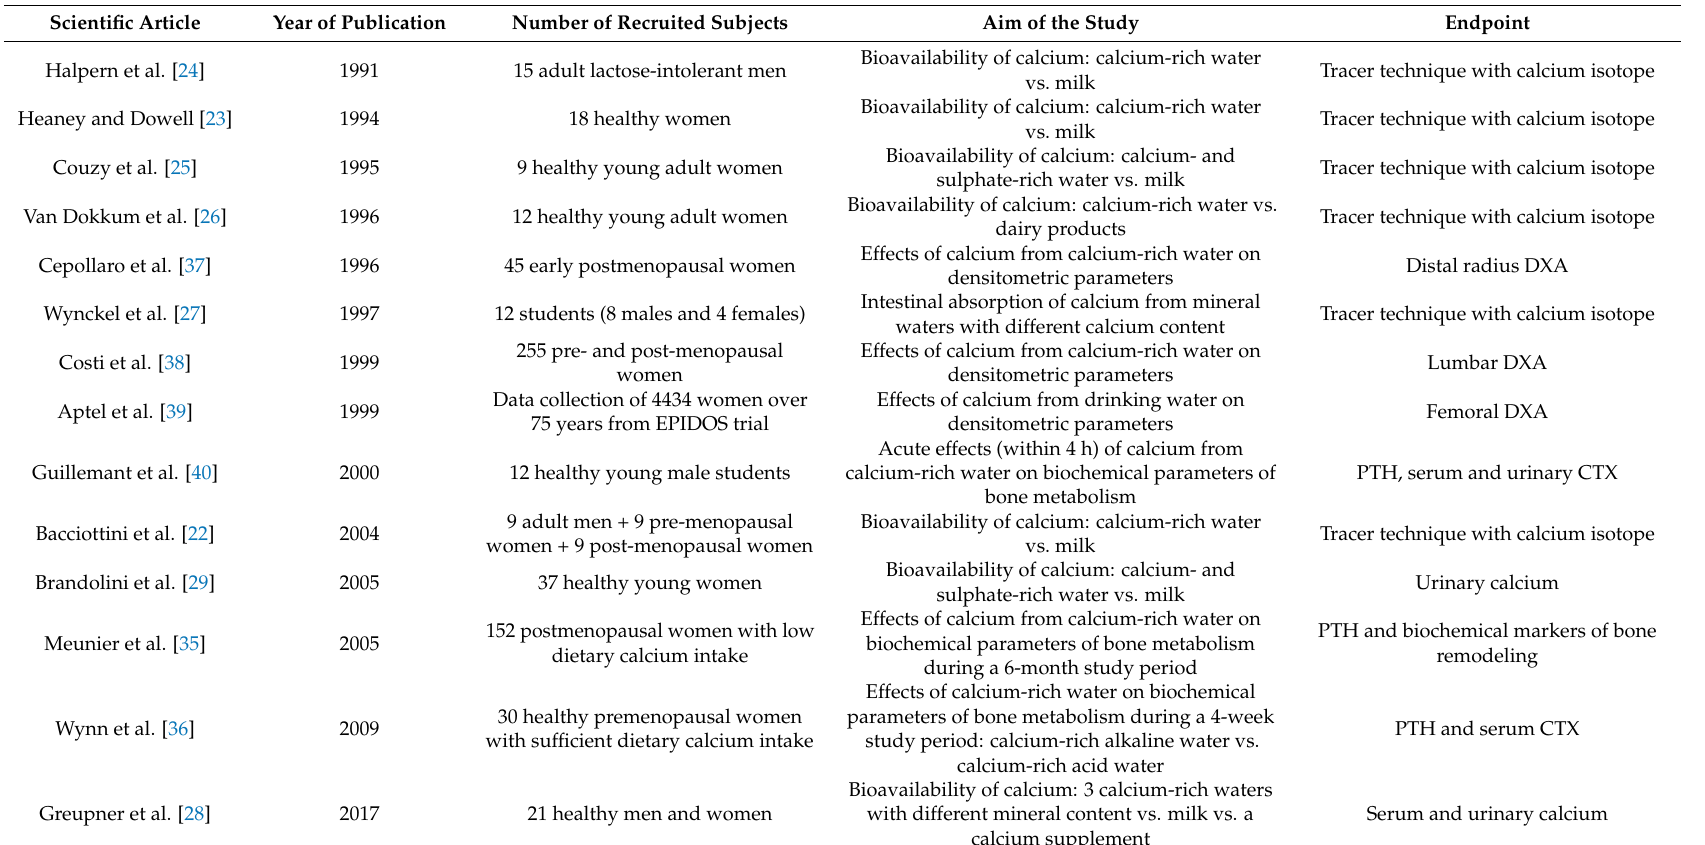
Table 2. Main characteristics of clinical studies investigating calcium bioavailability from mineral water and the effects of this ion on mineral and bone